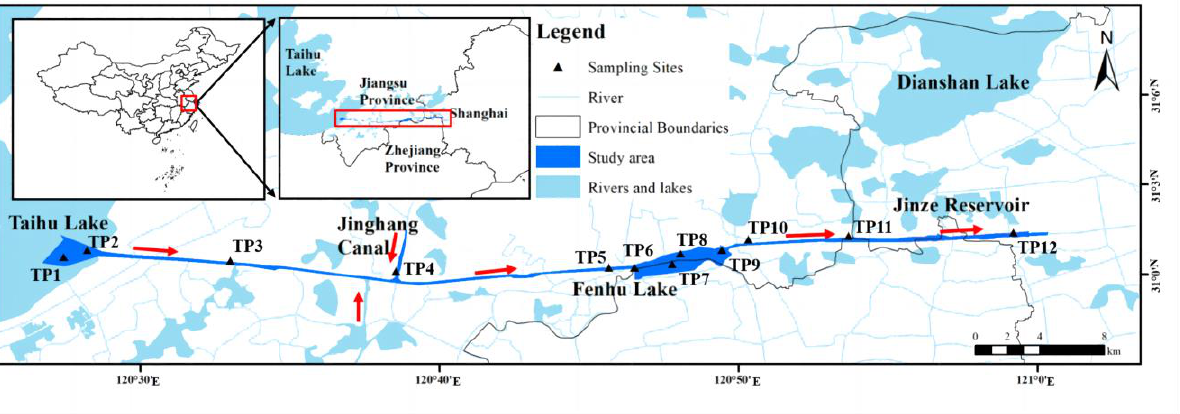
Figure 1. Maps showing the study area. The red arrows demonstrate the major river flow direc-